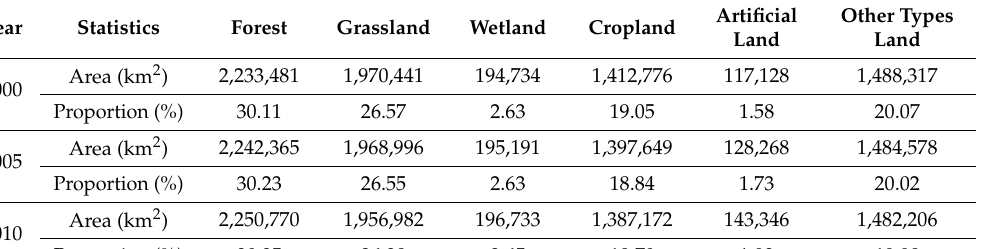
Table 3. The ecosystem composition and distribution in the Grain for Green Program (GGP) area in 2000, 2005, and 2010.